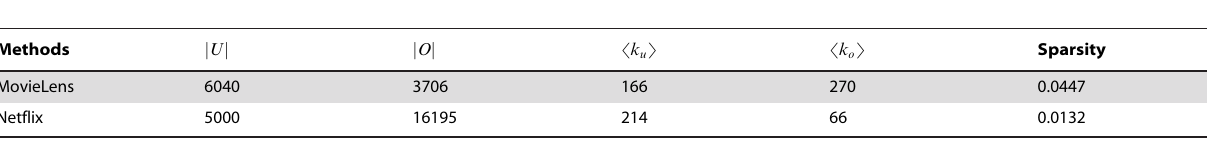
Table 1. Some basic characteristics of the real data sets considered in this paper.